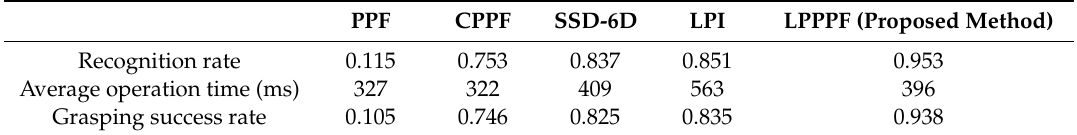
Table2. Performanceofdi ff erentcombinationmethodsingraspingwoodplanks.PPF:Pointpairfeature.